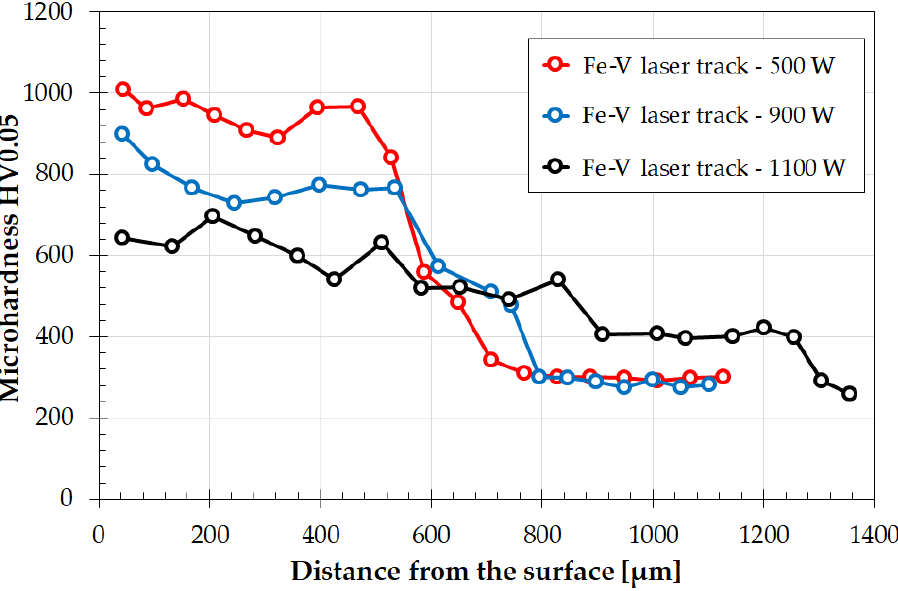
Figure 8. Microhardness profiles of multiple laser tracks for coatings produced using various laser beam powers: 500 W, 900 W, and 1100 W.